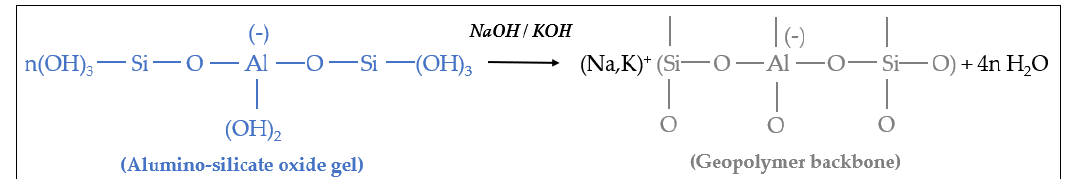
Figure 2. Dissolution and hydrolysis reaction of the alumino-silicate precursor.